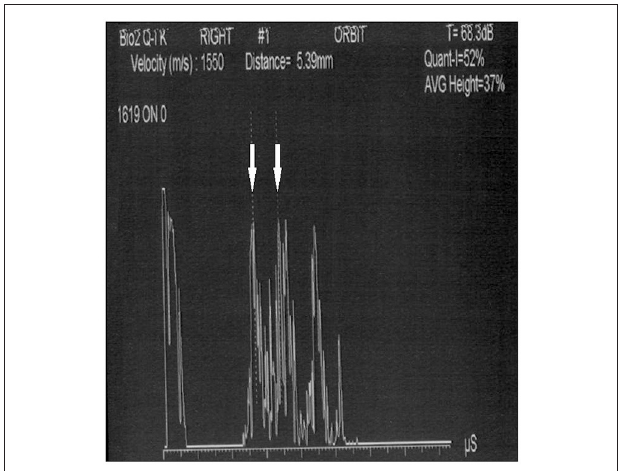
FIGURE 1 | Standardized A-scan image of the optic nerve, showing the two high spikes (white arrows) used to perform ONSD measurement (5.39mm).